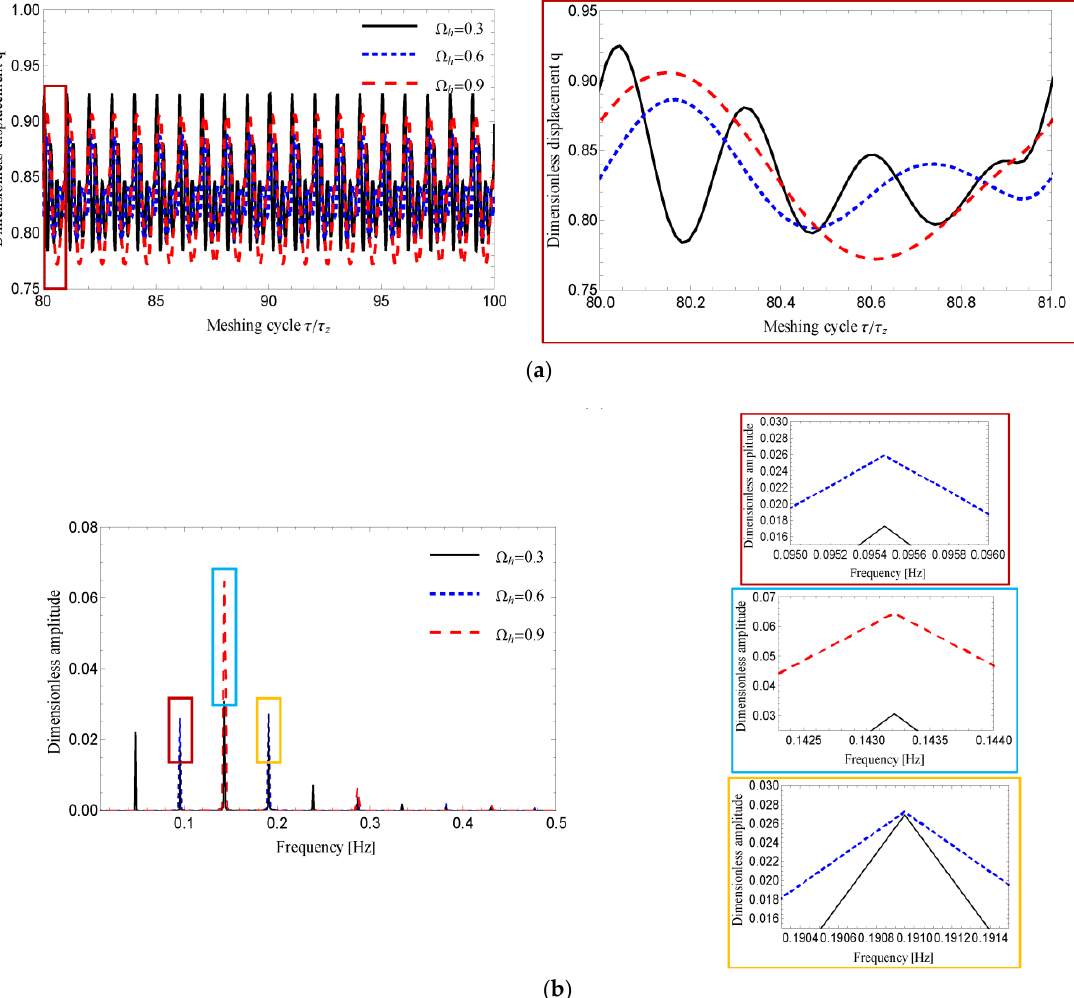
Figure 18. The dynamics characteristics with different 𝛺 ℎ : ( a ) time history diagram; ( b ) FFT spectrogram.